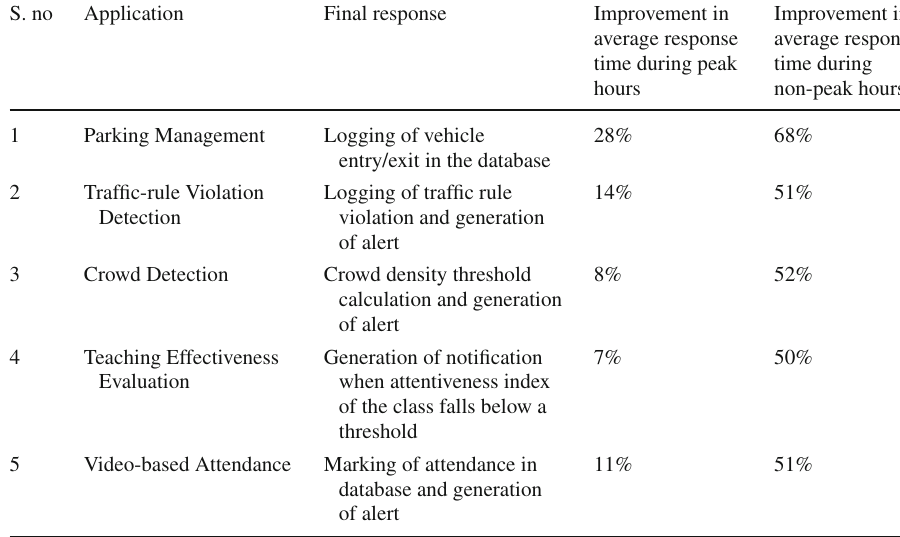
Fig. 8 Storage consumption for different video analytics applications with and without CVAF Table 6 Improvement in the average response time of different applications during peak and non-peak hours